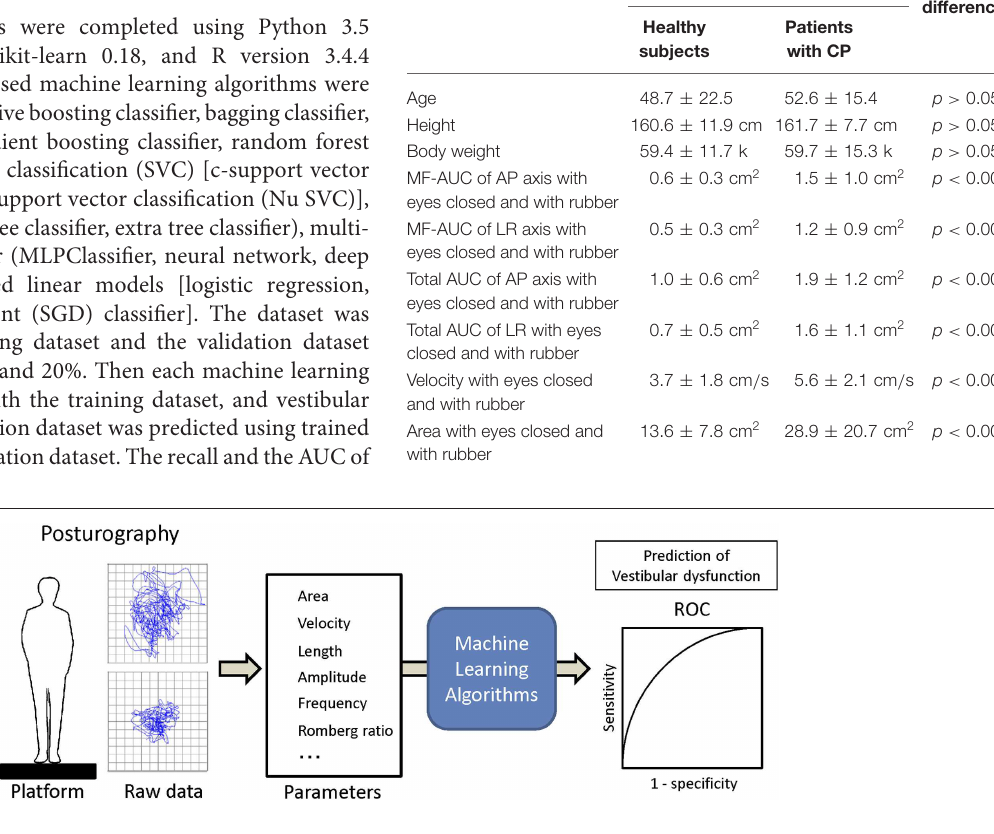
Frontiers in Neurology |